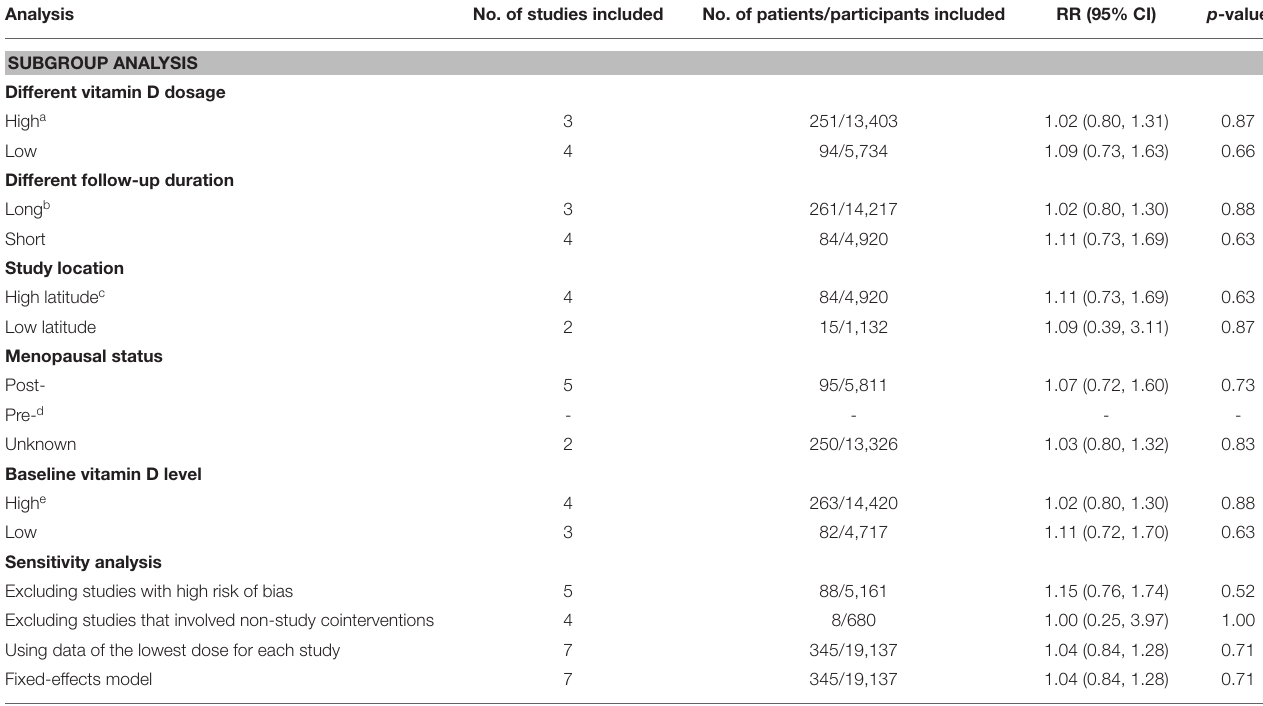
TABLE 2 | Subgroup analysis and sensitivity analysis for incidence of breast cancer. Analysis